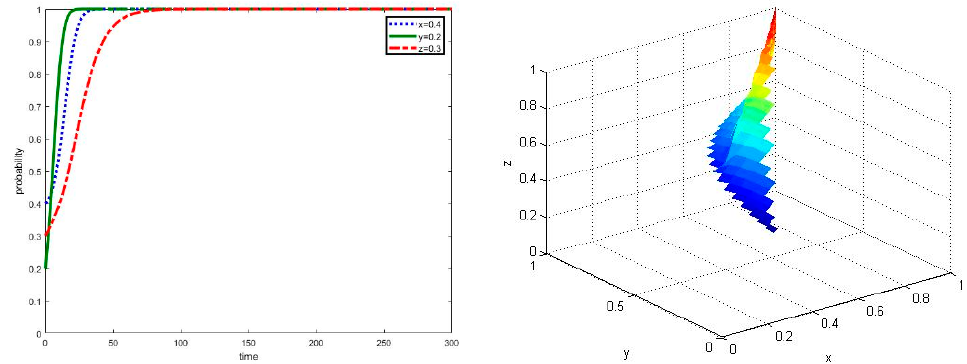
Figure 6. Simulation of dynamic evolution in the scenario of parameter =0.1 .